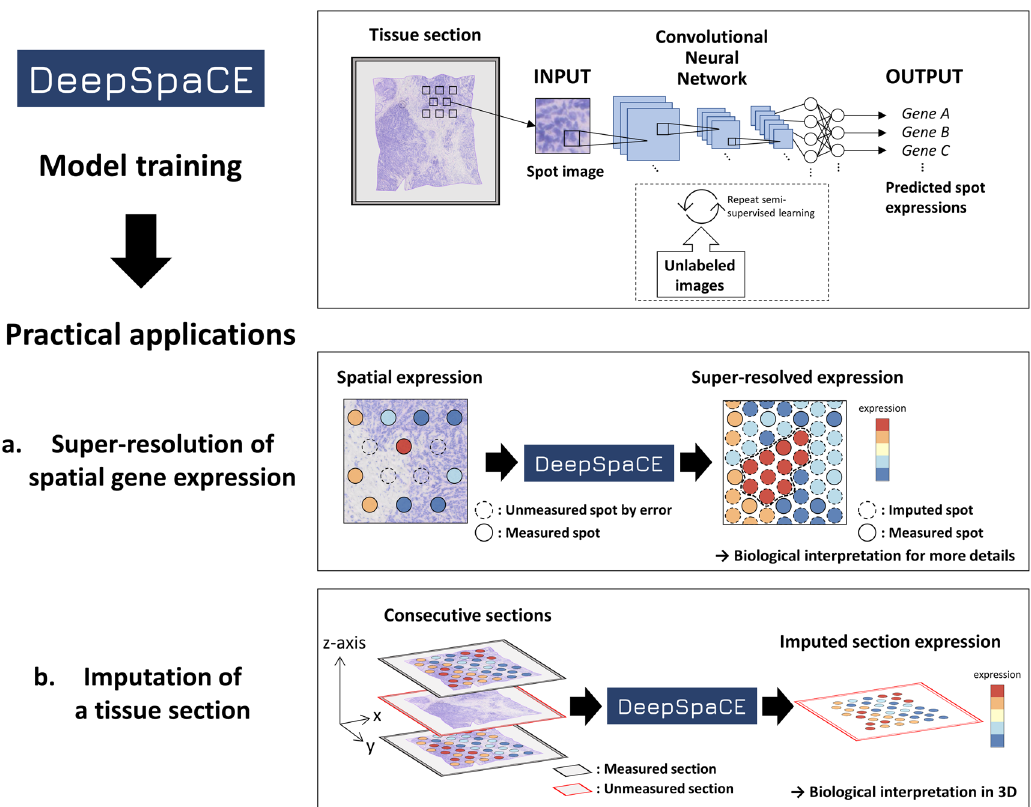
Figure 1. Overview of DeepSpaCE. Deep learning model for Spatial gene Clusters and Expression (DeepSpaCE) is a method for predicting gene-expression levels and transcriptomic cluster types from tissue spot images. DeepSpaCE is composed of two parts: the model training and gene-prediction parts. In the case of using semi-supervised learning as an option, unlabeled images are used to improve the prediction accuracy with predicted proxy labels. As practical applications of DeepSpaCE, we conducted super-resolution of spatial gene expression and tissue section imputation. ( a ) Super-resolution was used for predictions with unmeasured spot images (e.g., images among spots whose expression profiles were measured using the in situ capturing platform or images on spots with technical errors). Left spatial expression pattern shows that some spots lack expression value because of a technical problem such as potential permeabilization error (dotted circle). Right image shows an additional spatial expression pattern imputed by DeepSpaCE, and its highly expressed region in the center of the section (dotted line). It is challenging to infer a functional boundary such as cancer infiltration from spatial expression profiles of sparse spots (left). Spatial expression profiles of dense spots imputed by DeepSpaCE and their gene annotations enable delineating a functional boundary. ( b ) Tissue section imputation was used to predict gene-expression levels in one of the tissue sections within consecutive sections. By using DeepSpaCE, the unmeasured spatial expression profiles of the slide (red frame) can be imputed by at least one adjacent slide (black frame) whose expression profiles were measured using the in situ capturing